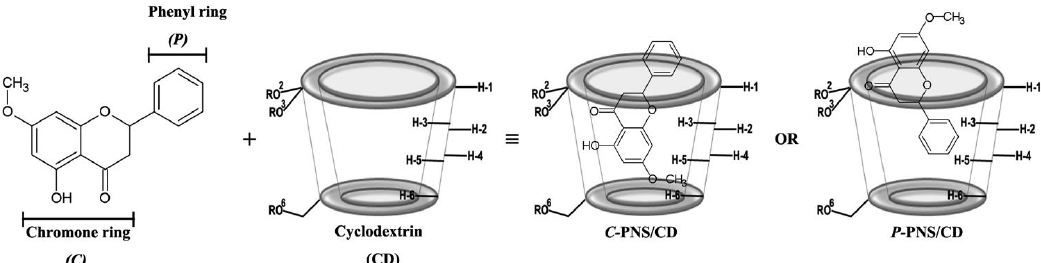
Figure 1. Two dimensional structures of two possible binding modes for the inclusion complex between pinostrobin (PNS) and cyclodextrin (CD) (shown as a truncated shape), where –R is –H, –CH 3 and –C 3 H 7 O for βCD, 2,6-DMβCD (heptakis-(2,6-di- O -methyl)-β-cyclodextrin) and HPβCD ((2-hydroxypropyl)-β-cyclodextrin), respectively.